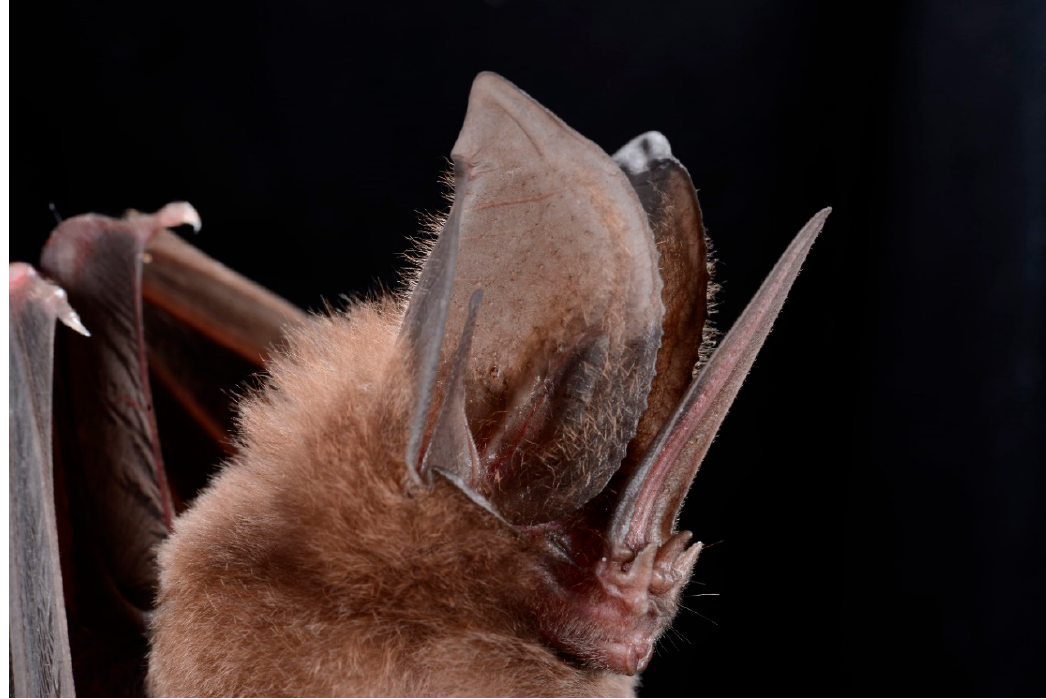
Figure 8. The first record of the Orinoco sword-nosed bat ( Lonchorhina orinocensis ), known previously from the Llanos of Colombia and Venezuela, is now documented in the Rupununi savanna of Guyana. There are three species with structuring that identifies the Venezuelan Llanos as a divergent lineage. In Trachops cirrhosis , there are at least seven distinct lineages comprising individuals from the Rupununi and Sipaliwini in a broadly sympatric clade with other samples from Guyana and